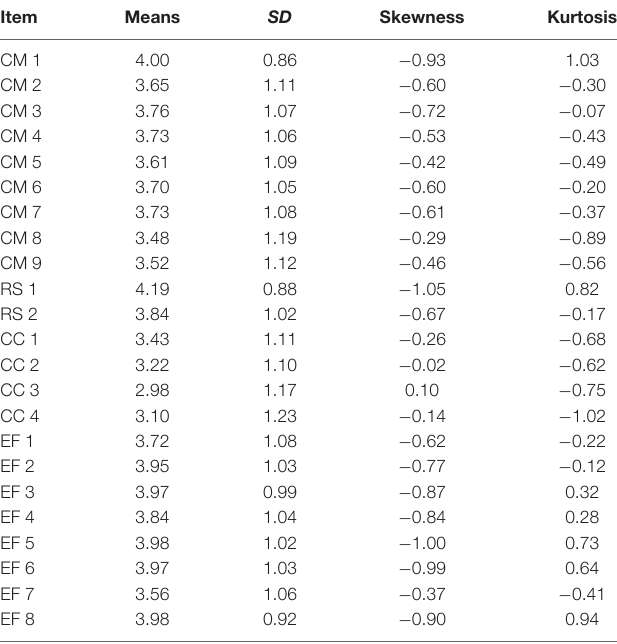
TABLE 3 | The means, SD s, skewnesses, and kurtoses of the items in subsample 2 ( n = 263). Item